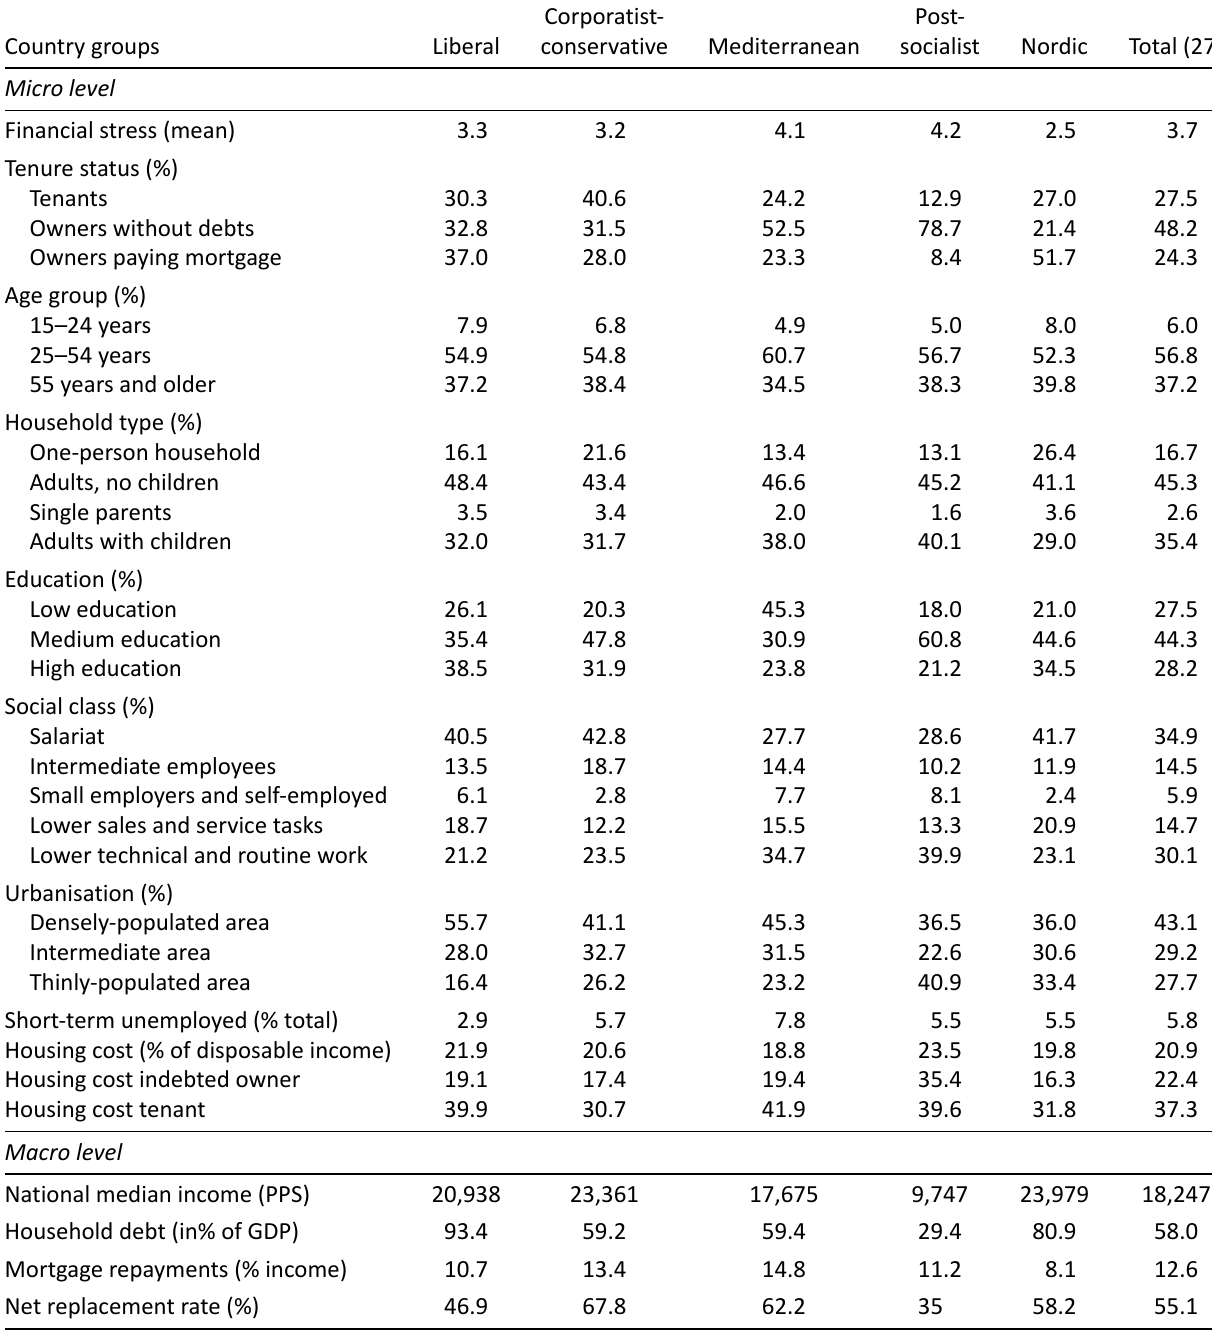
Table 1. Descriptive evidence for 27 European countries by welfare